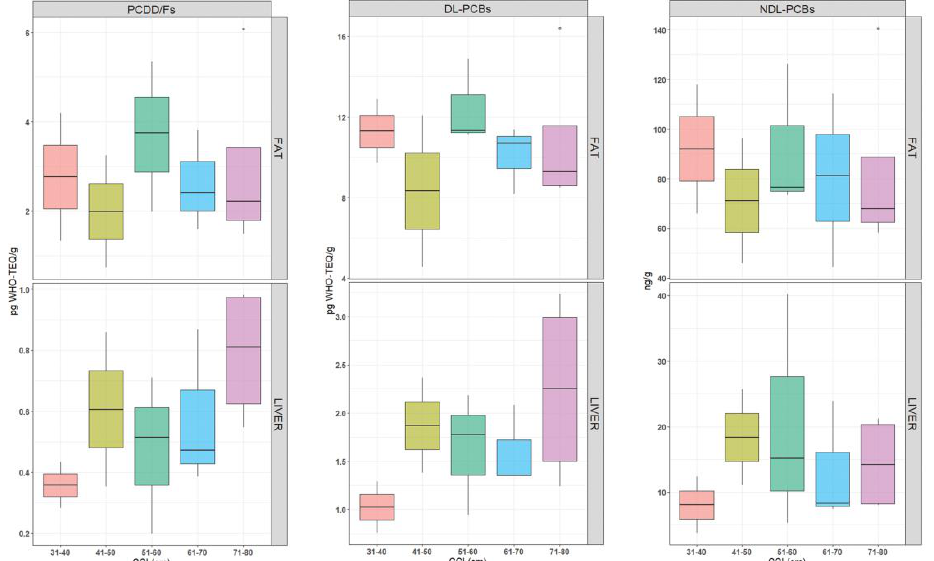
Figure 3. Box-plot showing the levels of PCDD/Fs, DL-PCBs (pg WHO-TEQ g-1), and NDL-PCBs (ng g − 1 ) in sea turtles sorted by CCL range in fat tissue (on the top) and liver (on the bottom). From left to right: 31–40 cm (pale red), 41–50 cm (olive green), 51–60 cm (green), 61–70 cm (cyan), and 71–80 cm (pink)